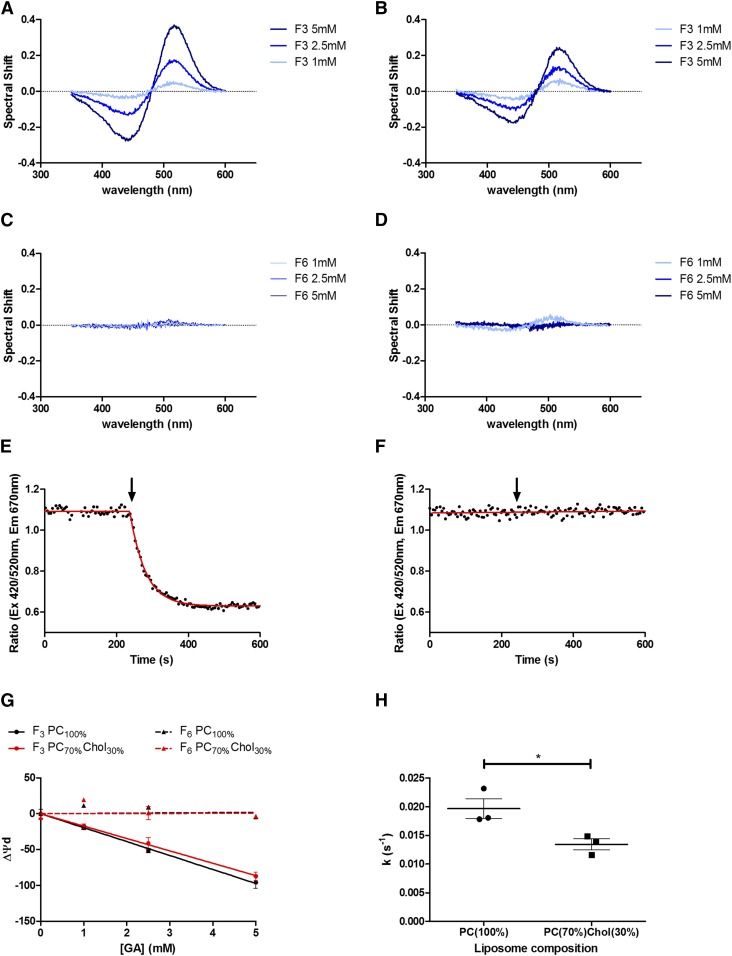
Comparing the interactions of F3 and F6 with artificial membrane systems and their effects on the membrane dipole potential. A–D: The fluorescence excitation spectra of di-8-ANEPPs-labeled liposomes shifts in response to F3, but not F6, indicative of a reduction in the membrane dipole potential. Fluorescence difference spectra obtained by subtracting excitation spectra (λem = 670 nm) of di-8-ANEPPs-labeled PC100% [PC(100%)] (A, C) and PC70%Cholesterol30% [PC(70%)Chol(30%)] (B, D) liposomes (400 μM) from those obtained on addition of the indicated concentrations of F3 (A, B) or F6 (C, D). Before subtraction, each spectrum was normalized to their integrated areas so that the difference spectra only reflected the spectral shift. In each experiment, temperature was maintained at 37°C. A dual wavelength ratiometric measurement of the membrane dipole potential was made on addition of F3 (E) or F6 (F) to di-8-ANEPPs-labeled PC100% liposomes at the indicated time (arrows represent 5 mM additions). Samples were excited at 420 and 520 nm and emission recorded at 670 nm. The ratio R(420/520) was calculated (black dots) before each titration was fit (red line) to a plateau followed by one-phase decay (equation 1) or straight line (equation 2) using an extra sum-of-squares F-test to determine the best fitting model in each case. G: Addition of F3 (solid lines), but not F6 (dashed lines), to PC100% (black) and PC70%Cholesterol30% (red) artificial membrane systems induced a dose-dependent reduction in the membrane dipole potential. All experiments n = 3; mean ± SEM. H: The rate of change in membrane dipole potential on addition of 5 mM F3 to PC100% liposomes was significantly greater (two tailed unpaired t-test, *P = 0.0352).